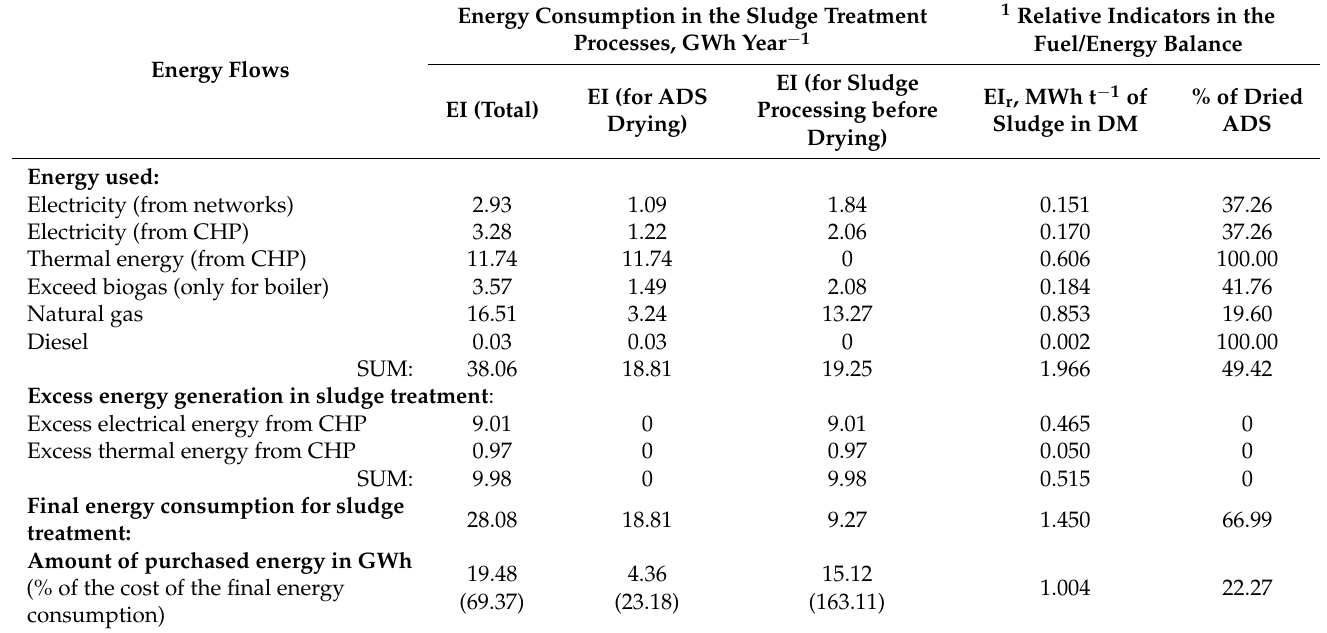
Table 1. Energy used for sludge treatment in the sewage treatment plant (current